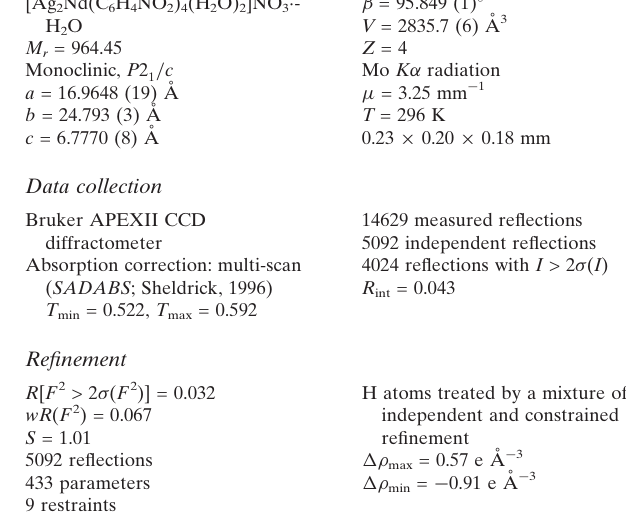
Absorption correction: multi-scan ( SADABS ; Sheldrick, 1996) T min = 0.522, T max = 0.592